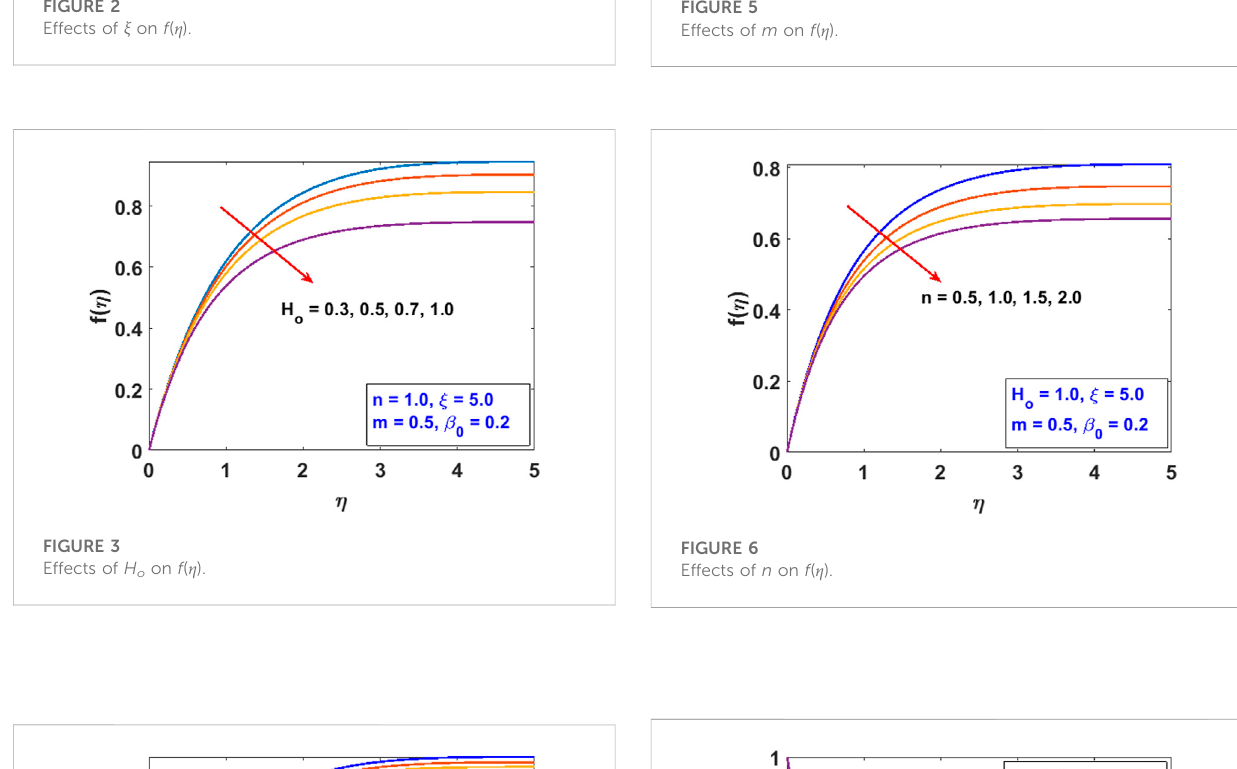
FIGURE 2 Effects of ξ on f ( η ).